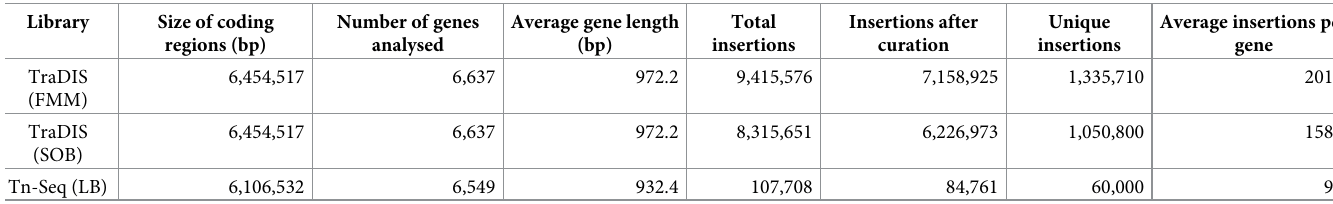
Table 2. Comparison of transposon mutant library sizes and average insertion frequencies between TraDIS and the Tn-Seq analysis from [24]. Library Size of coding Number of genes Average gene length Total Insertions after Unique Average insertions per regions (bp) analysed (bp) insertions curation insertions gene TraDIS 6,454,517 201.2 (FMM) TraDIS 158.2 (SOB) Tn-Seq (LB)